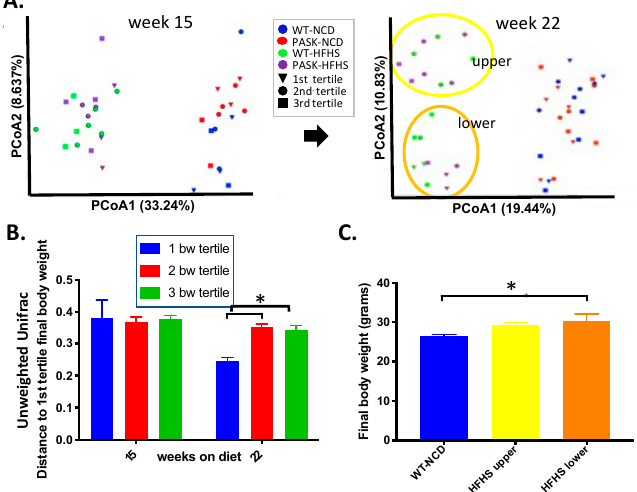
Figure 4. Gut microbial composition is associated with weight gain on an HFHS diet. ( A ) Unweighted UniFrac principal coordinates analysis (PCoA) distances in microbial diversity plot of week 15 samples and week 22 samples coded by final body weight tertile per cohort, with oval outline of the HFHS lower cluster (orange) and upper cluster (yellow). ( B ) Comparison of unweighted UniFrac [54] distances by final body weight tertile of HFHS males at 15 and 22 weeks. ( C ) Final body weights of HFHS mice divided by unweighted UniFrac PCoA cluster compared to the WT-NCD. QIIME2/2017.10. software package [43] was used to analyze the microbiome and produce ( A ). ANOVA was performed from ( B ) summary QIIME2/2017.10. data using GraphPad Prism version 8.0.0 (GraphPad Software, San Diego, CA, USA), and for ( C ), ANOVA in JMP Pro 14, to determine significance followed by post hoc Dunnett’s analysis for comparison with WT-NCD ( p < 0.05 is indicated by “*”).